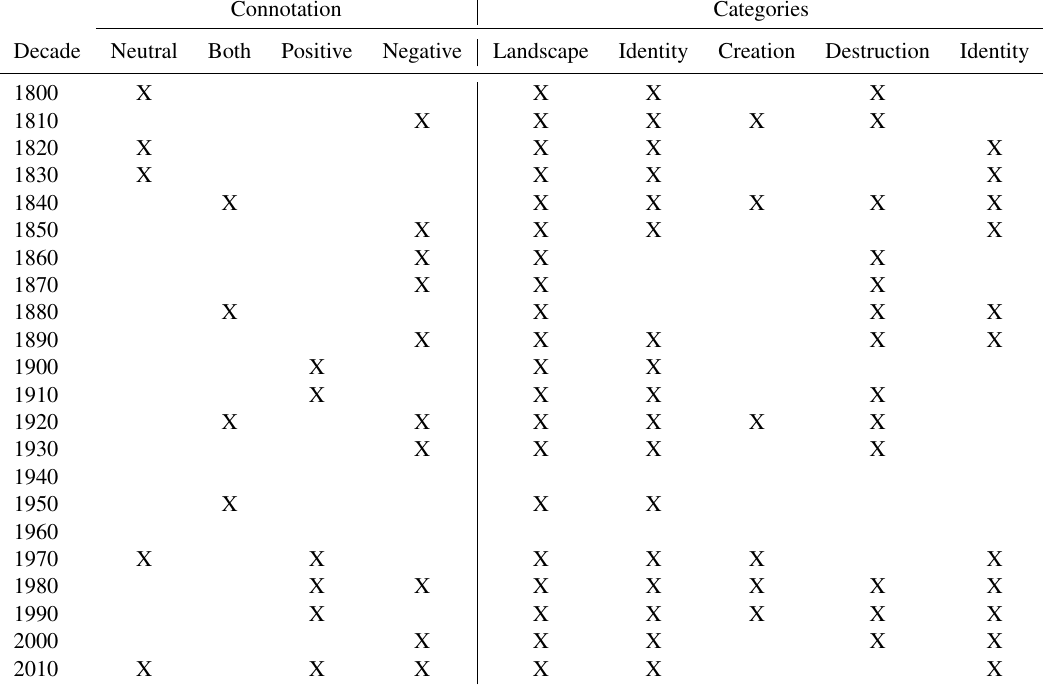
Table 4. Poem connotation and categories by decade. In this table each decade was considered to have an associated connotation if at least one poem written in this decade was considered to be either neutral, positive, negative, or both. Similarly, a particular decade was assumed to be associated with an emergent category if at least one of the poems that were written in that decade was categorised as